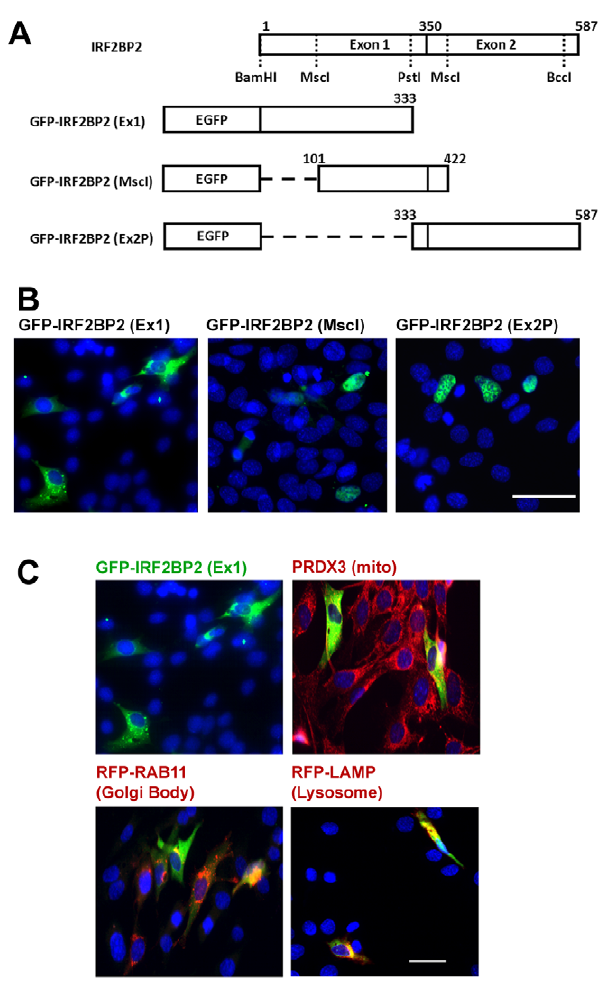
Figure 2. Nuclear localization signal is contained within the C- terminal half of IRF2BP2. A. Diagram of GFP fusion IRF2BP2 deletion contructs used to localize the NLS. B. The N-terminal fragment, GFP- IRF2BP2(Ex1) is cytoplasmic, whereas the middle, GFP-IRF2BP2(MscI), and C-terminal, GFP-IRF2BP2(Ex2P), fragments are nuclear in C 2 C 12 myoblasts. C. The N-terminal fragment is targeted to the lysosome in C 2 C 12 myoblasts. Mitochondrial-specific peroxiredoxin 3 (PRDX3) and Golgi body-sepcific Ras-related protein 11 (Rab11) did not, whereas the lysosome-associated membrane protein (LAMP) did co-localize with GFP-IRF2BP2(Ex1). Scale bars, 50 m